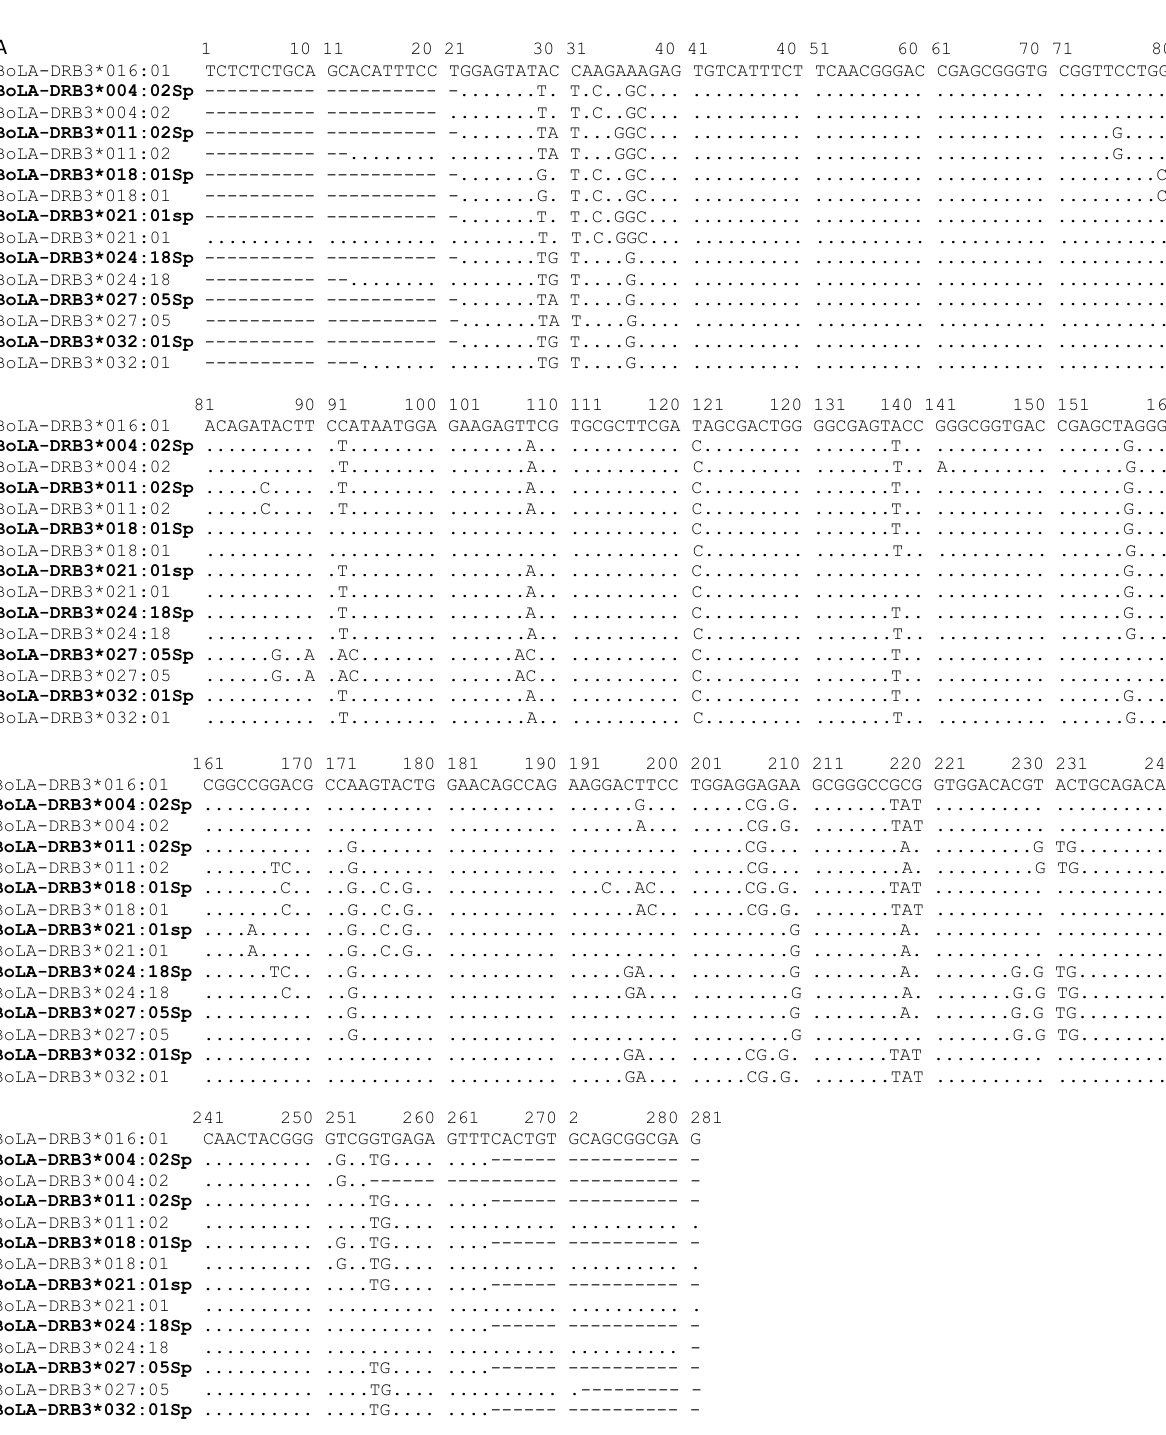
Figure 1. Alignment of the nucleotide ( A ) and the predicted amino acid ( B ) sequences of the β1 domain encoded by seven new BoLA-DRB3 alleles (accession numbers , LC569725 for BoLA-DRB3*004:02Sp, LC569726 for BoLA-DRB3*011:02Sp , LC569729 for BoLA-DRB3*018:01Sp , LC569731 for BoLA-DRB3*021:01sp , LC569733 for BoLA-DRB3*024:18Sp , LC569735 for BoLA-DRB3*027:05sp , and LC569739 for BoLA-DRB3*032:01sp ) derived from 225 Sudan native cattle (113 animals of the Baggara native, 60 Butana, and 52 Kenana Sudan native cattle breeds). New alleles are indicated in bold. Numbering refers to amino acid positions in the mature protein. Nucleotide and amino acid residues identical to those encoded by the BoLA-DRB3 cDNA clone NR-1 are indicated by dots (Aida et al., 1995). Missing data are indicated by dashes. Closer BoLA-DRB3 alleles with new variants are also included in the figure. Id. = Nucleotide or amino acid identity in